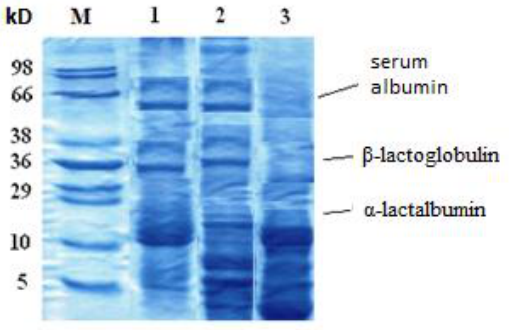
Fig. 8. Electrophoregram of enzymatic hydrolyzate of whey proteins with the different duration of hydrolysis: 1 – 30 min, 2 – 60 min, 3 – 90 min. M is a marker Roti-Mark Standard, 5–98 kD (Carl Roth, Germany). Table 9. Characteristic of hydrolyzates of serum proteins, % Level of hydrolysis, with the duration of, min Parameter weakly, 30 moderately, 60 deeply, 90 Percentage of split proteins in the hydrolyzate: α-lactalbumin 11.3 ± 0.6 45.5 ± 2.3 98.3 ± 4.9 β-lactoglobulin 5.6 ± 0.3 28.7 ± 1.4 77.1 ± 3.8 bovine serum albumin 0 13.9 ± 0.7 58.4 ± 2.9 Percentage of fraction with the molecular weight of <500 D 6.8 ± 0.3 12.4 ± 0.6 63.4 ± 4.7 Ratio of α-amino and total nitrogen 3.5 ± 0.2 8.8 ± 0.4 60.2 ±